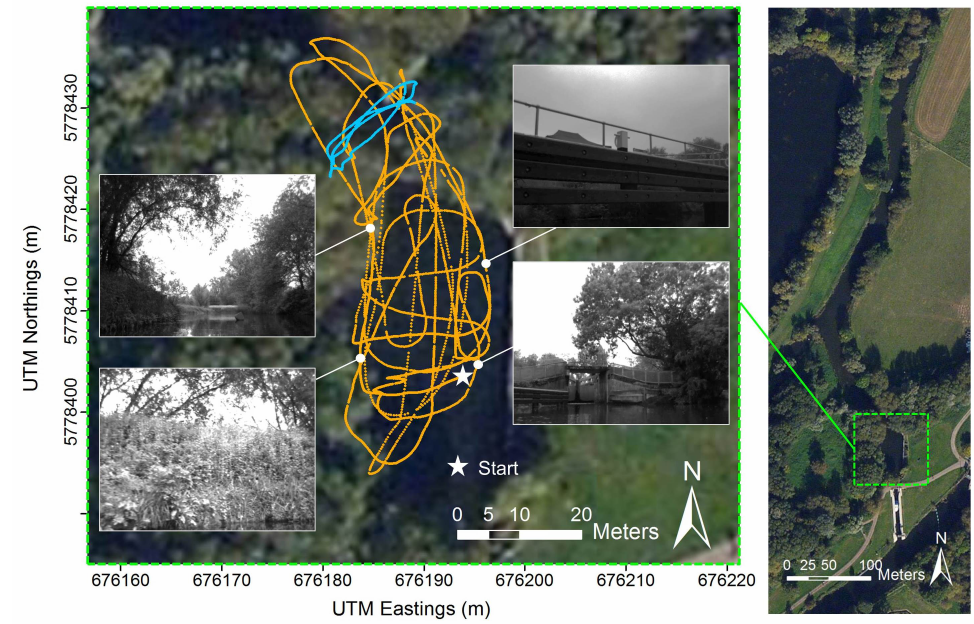
Figure 1. Full (orange) and discharge measurement (blue) trajectory with exemplary left intensity image